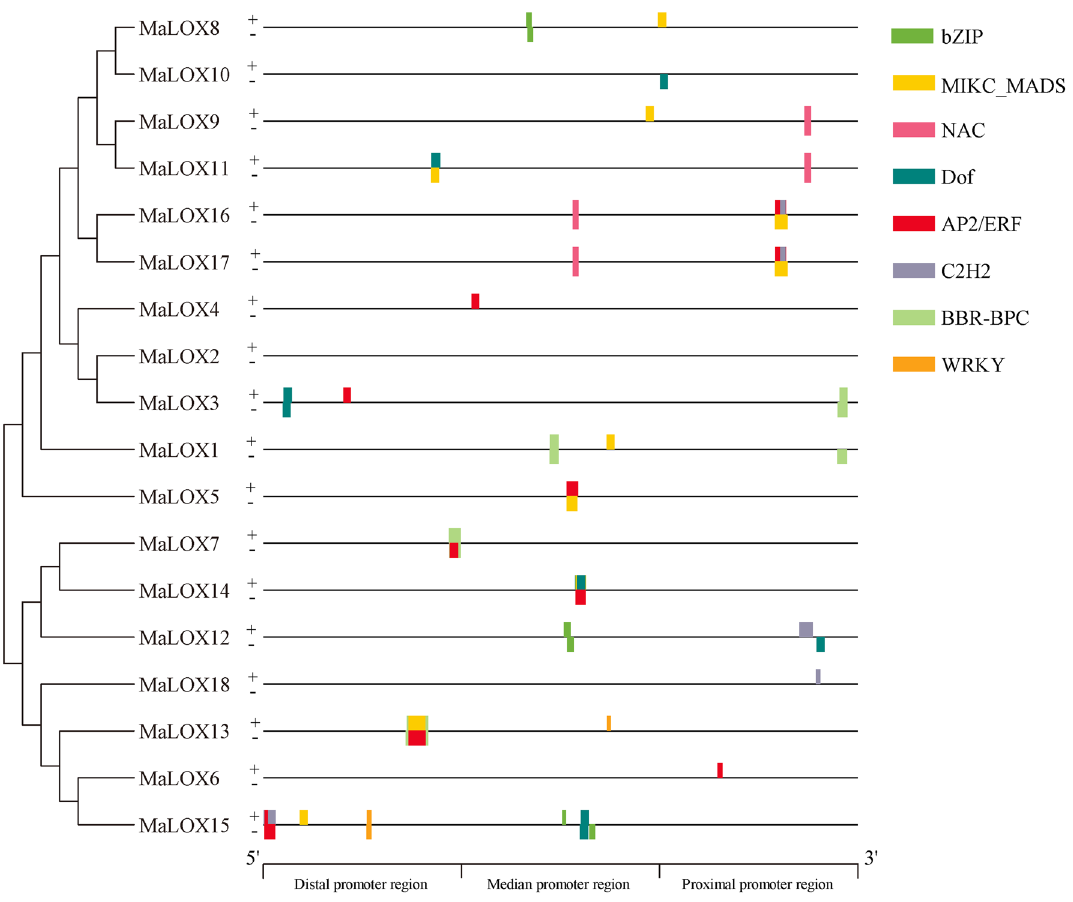
Figure 7. Transcription factor binding sites predicted in the promoters of MaLOXs. Boxes of different colors represent different transcription factor families. " + " and "−" represents positive and negative strand,